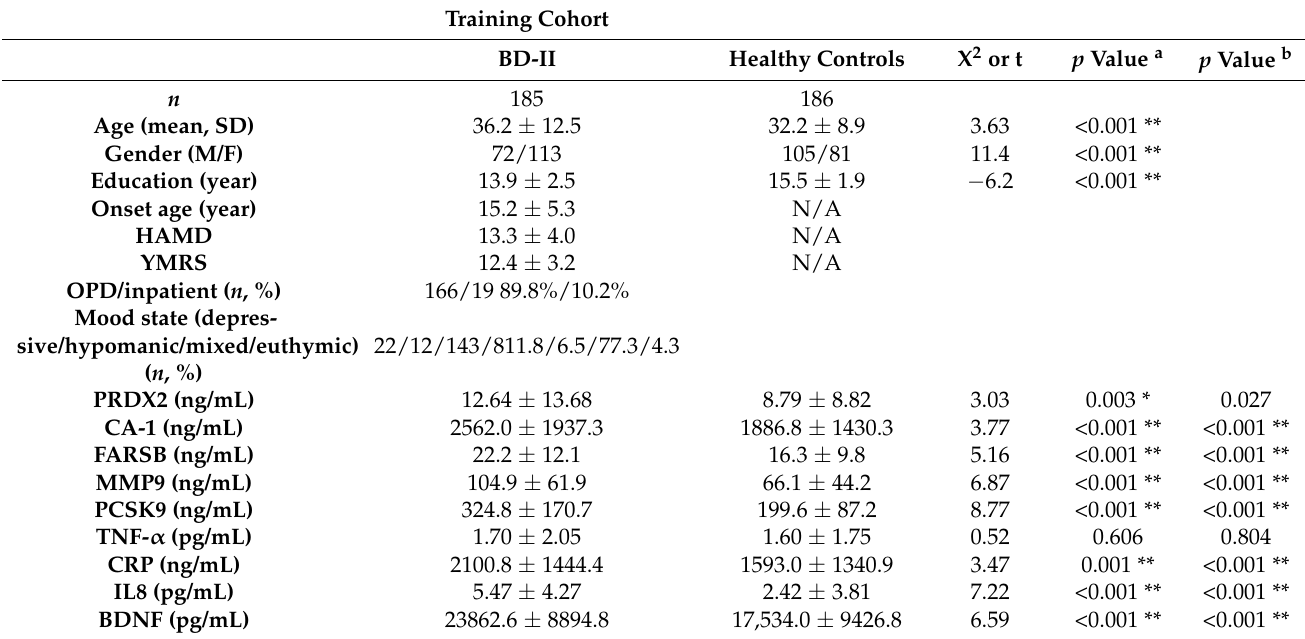
Table 1. Clinical and demographic data of patients with bipolar II disorder (BD-II) and healthy controls. Training Cohort BD-II Healthy Controls X 2 or t p Value a p Value b